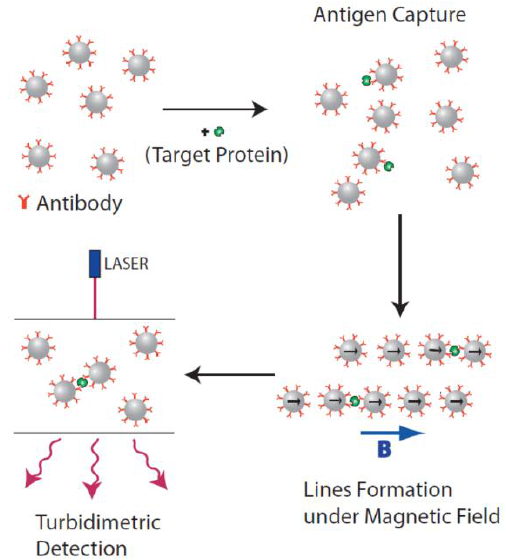
Figure 9. Sketch of analyte detection by magnetically accelerated particle dimer formation. Antigen analyte is captured by magnetic particles functionalized by either polyclonal or two different types of monoclonal antibodies, and under the action of an externally applied magnetic field, the particles assemble in chains, thus accelerating the formation of particle doublets via bound antigen. Once the magnetic field is turned off again, the doublets remain stable due to the bound analyte, and the concentration of doublets versus single magnetic particles can be quantified by turbidimetric (extinction) measurements. Reprinted with permission from [225]. Copyright (2006) National Academy of Sciences, USA.